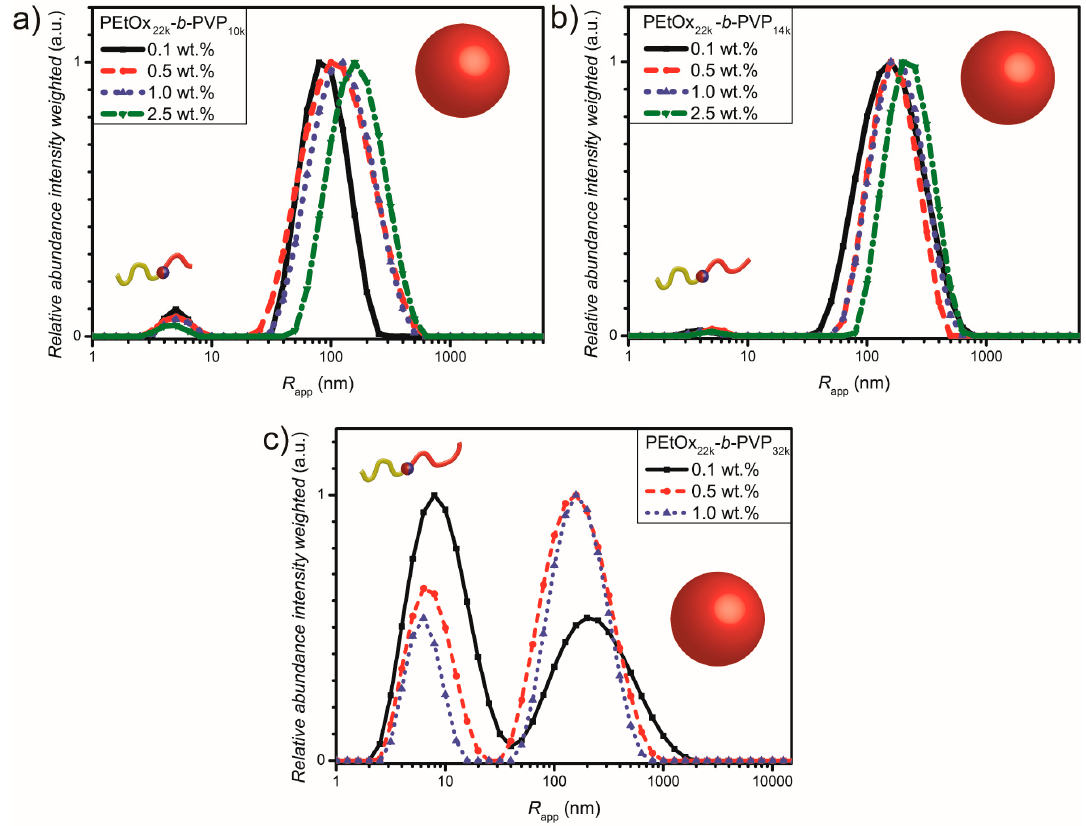
Figure 2. Intensity weighted particle size distribution curves obtained via DLS at various concentrations in water at 25 °C: ( a ) PEtOx 22k - b -PVP 10k ; ( b ) PEtOx 22k - b -PVP 14k and ( c ) PEtOx 22k - b - PVP 32k .